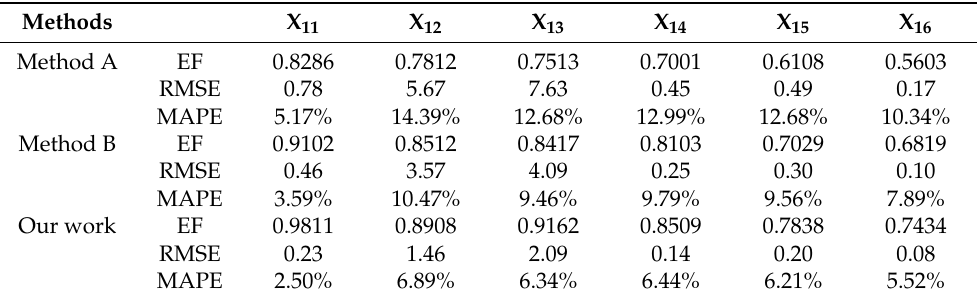
Table 8. Measurement accuracies of the scale-related morphological traits using the Euclidean Clustering method, Facet Region Growing method, and our